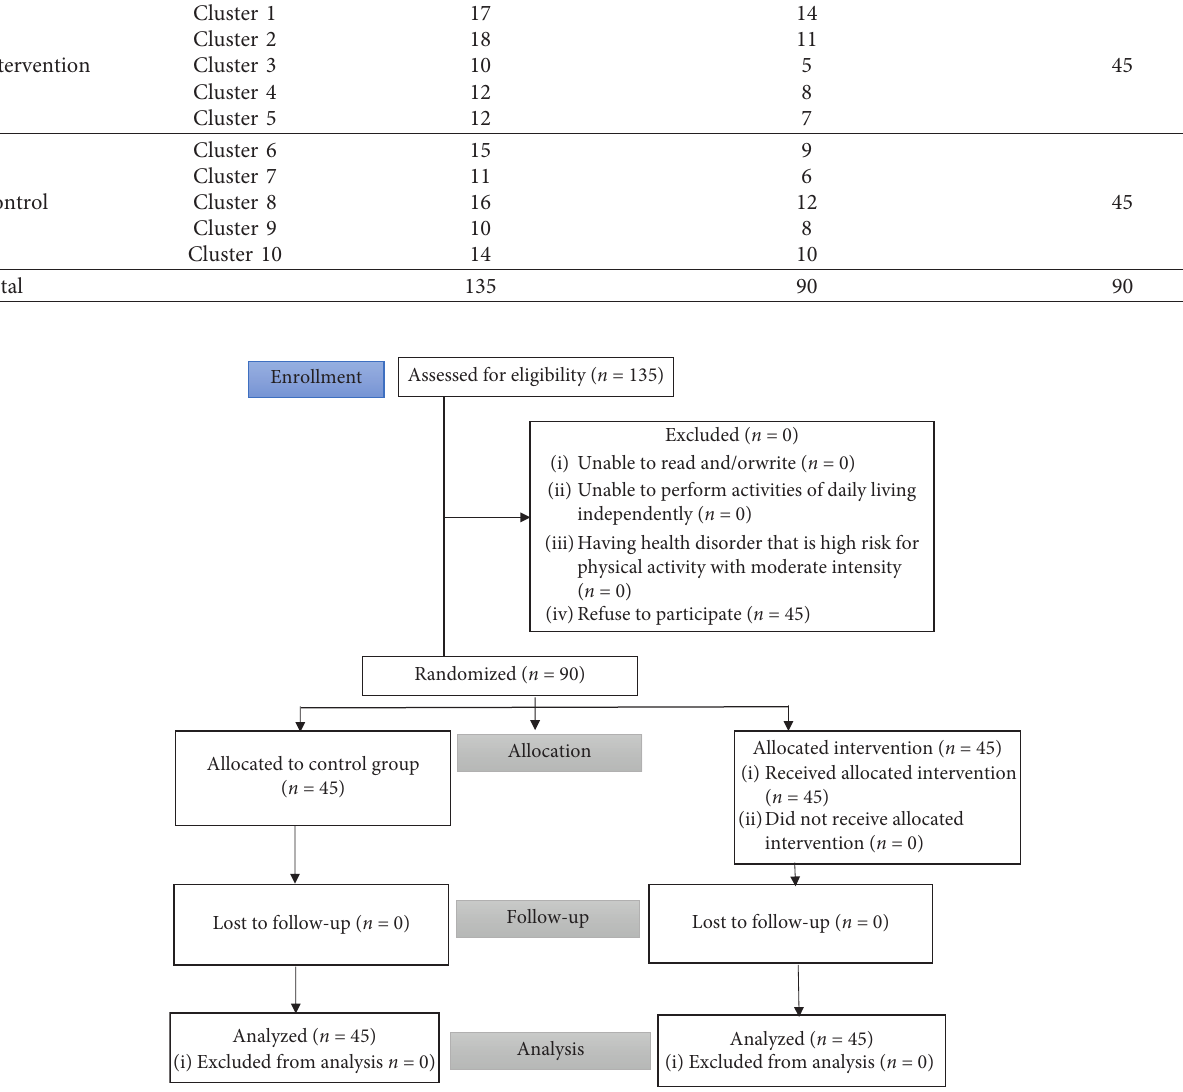
Figure 1: CONSORT flow diagram of participants. Table 2: Characteristics of community health